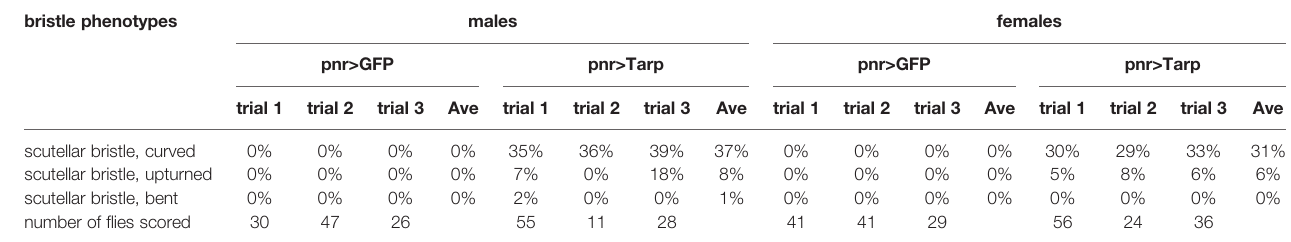
TABLE 1 | Frequency of bristle phenotypes in control and Tarp-expressing fl ies using pnr-GAL4. bristle